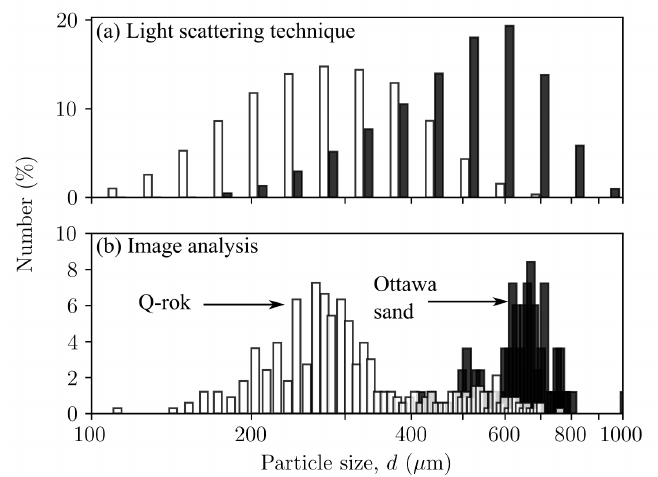
Figure 6. Number distribution from ( a ) laser light scattering technique, and ( b ) image analysis for Ottawa sand and